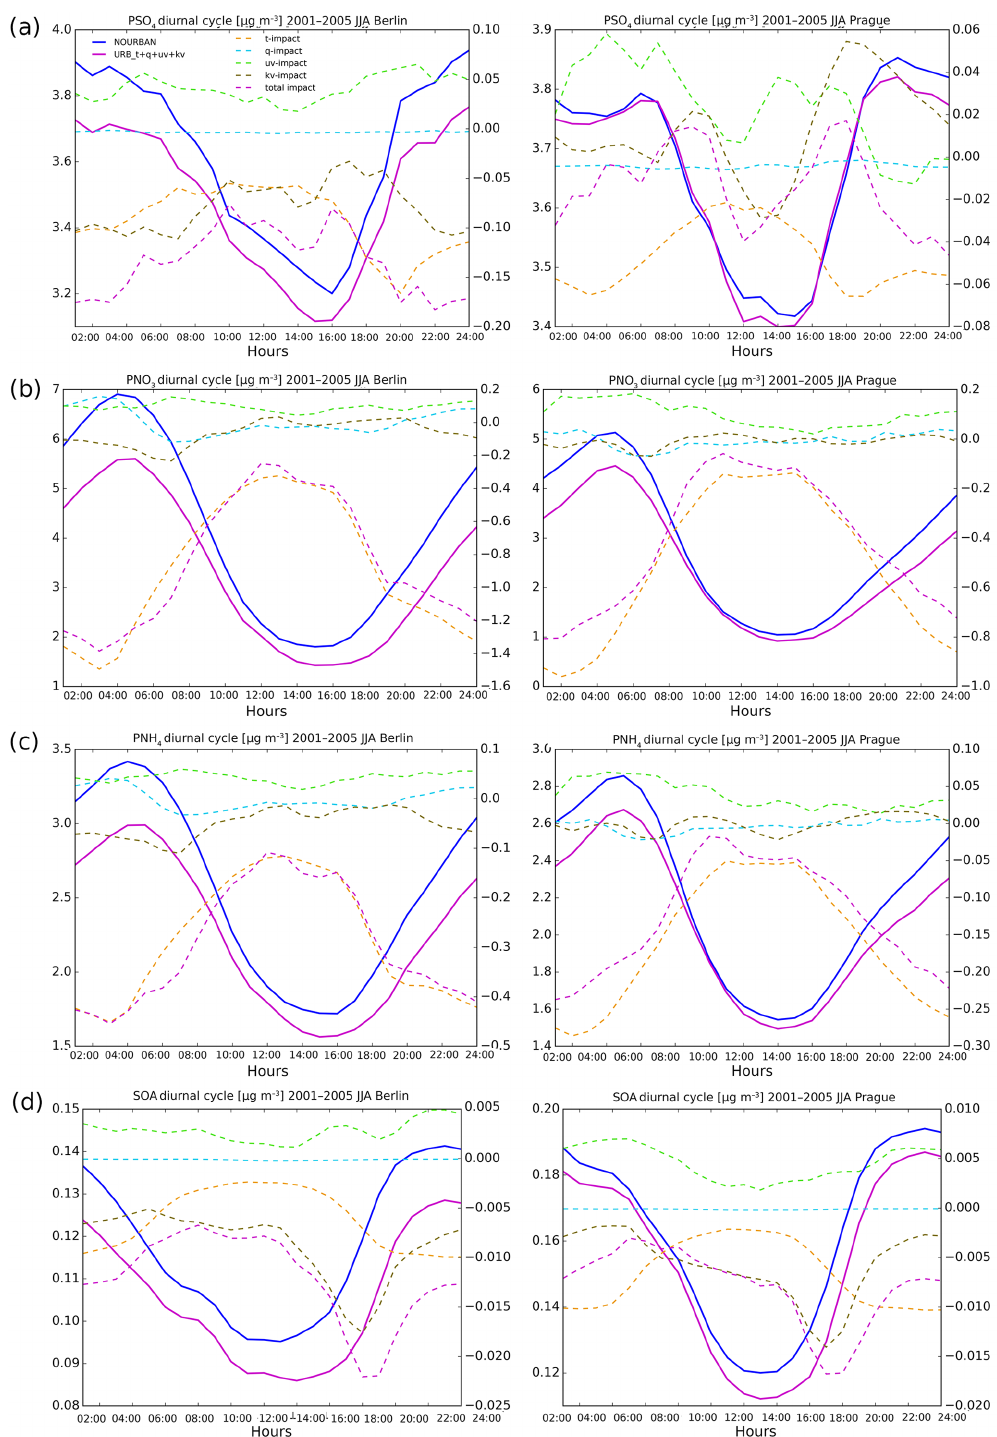
Figure 11. Impact of urban canopy meteorological forcing on (a–d) PSO 4 , PNO 3 , PNH 4 and SOA average diurnal cycle of surface concen- trations for the 2001–2005 JJA period for two selected cities (Berlin and Prague) in µgm − 3 . Bold lines represent the absolute concentrations (left y axis) for the NOURBAN run (blue) and the total impact URB_t+q+uv+Kv run (purple). Dashed lines (right y axis) show the change due to changes of individual meteorological components (temperature – orange, humidity – aquamarine, wind – green, turbulence – olive and total impact –